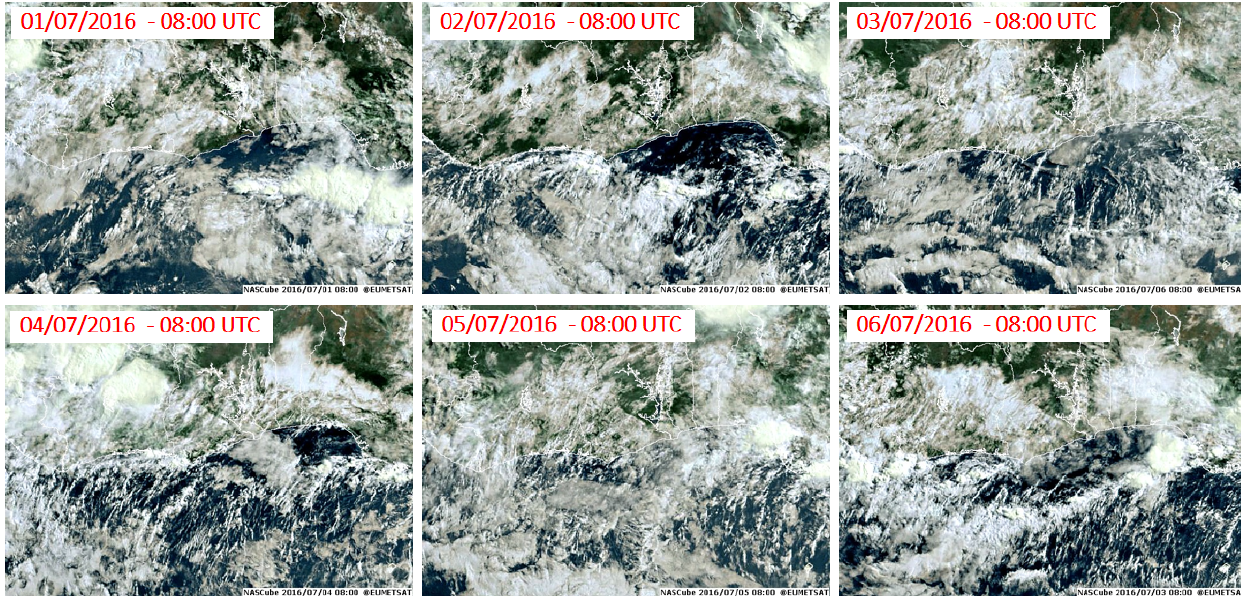
Figure A4. Images by the Spinning Enhanced Visible and Infra-Red Imager (SEVIRI) provided by EuMetSat and NAScube over the studied domain at 08:00UTC for the period 1–6 July 2016.